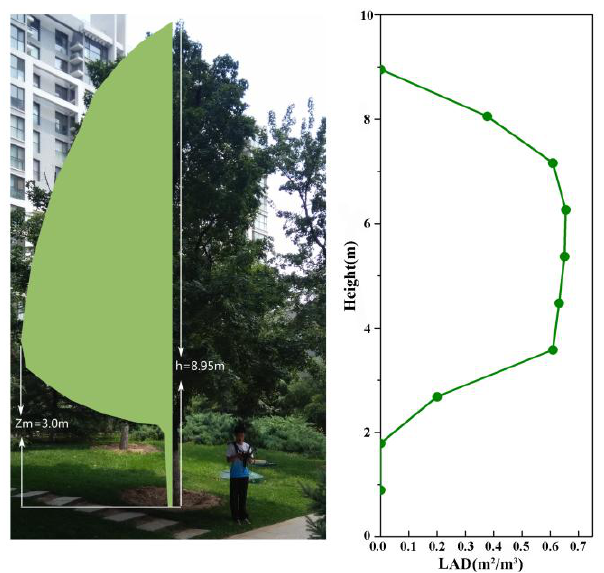
Figure 3. Photo of a mono maple ( Acer mono Maxim) and its LADs versus height.